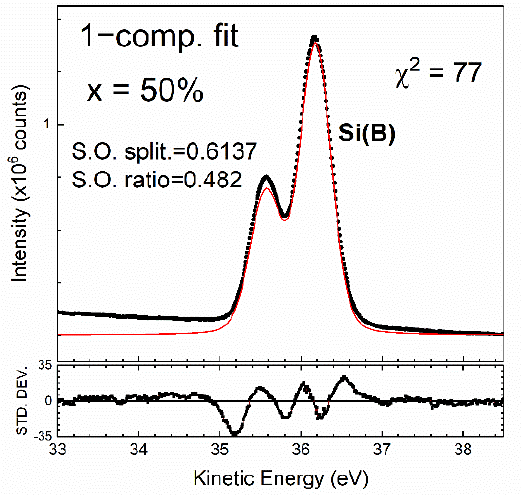
Figure 7. Fit to the clean Si 2p core-level spectrum based on the assumption of one component. The fitted results of χ 2 , spin–orbit splitting and the spin–orbit ratio are marked. The bottom panel presents a plot of the standard deviation of the fitted line and the spectral line. The Si(B) component corresponds to the Si atoms in the bulk of the SiGe film.